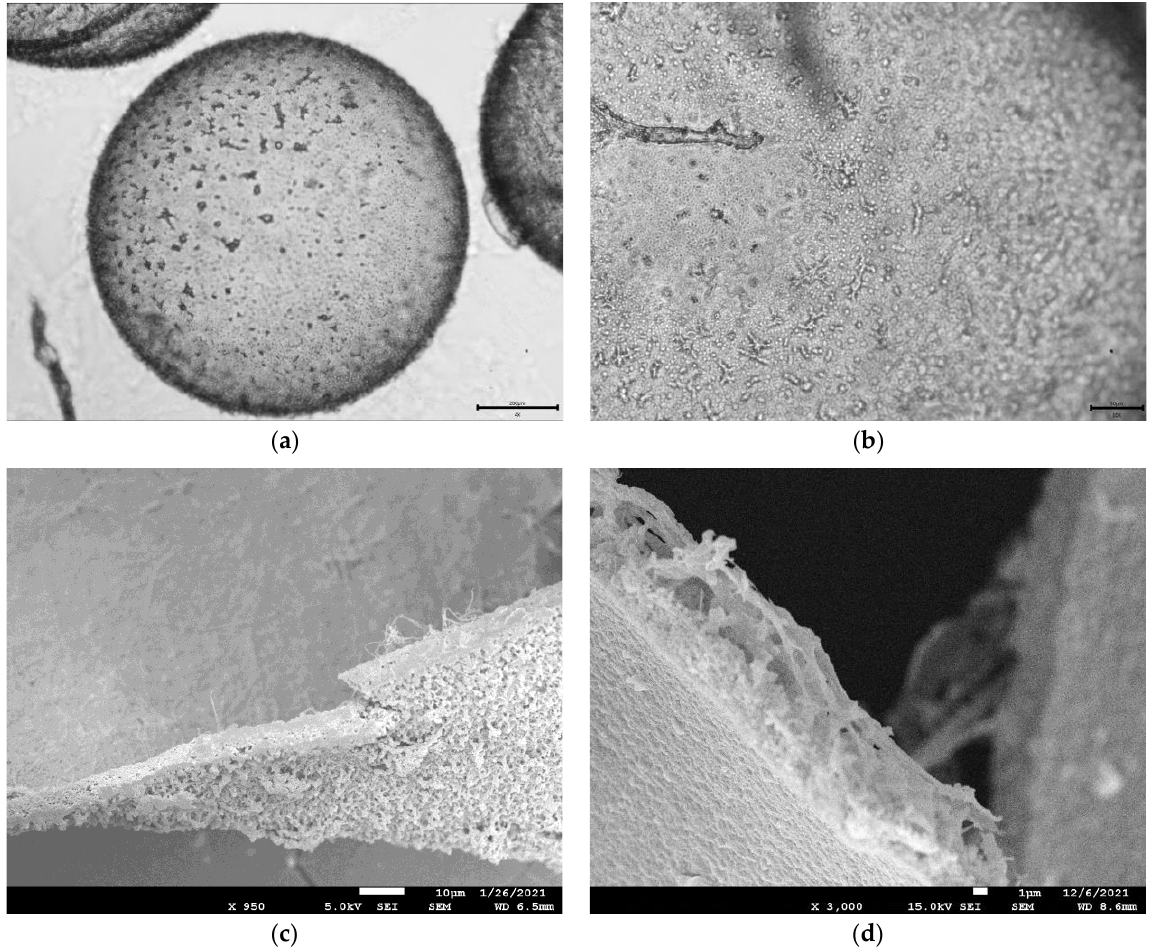
Figure 5. Images of a formed PECM. ( a , b ) Brightfield images of PECM. ( c , d ) SEM images of the cross-sectional view of the capsule wall showing the internal and external membrane surfaces.